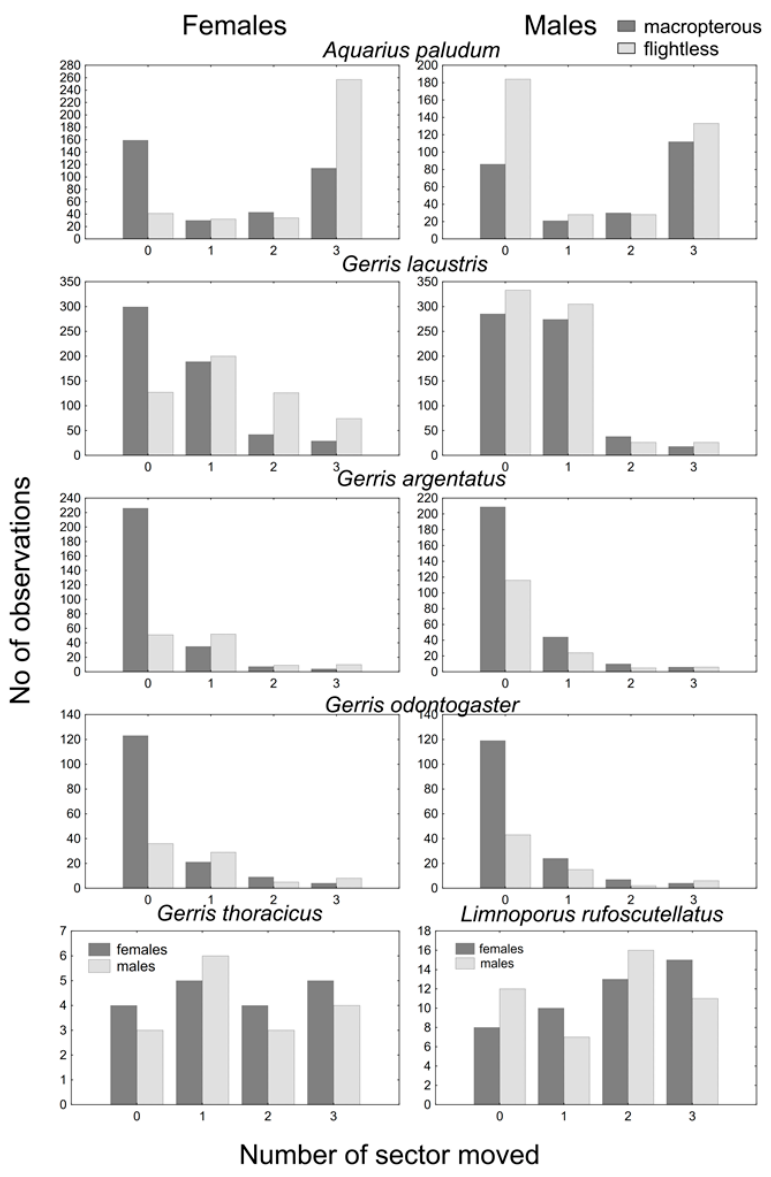
Figure 1. The score of within site movement. Both sexes and wing morphs are displayed for A. paludum , G. lacustris , G. argentatus and G. odontogaster ; only macropterous bugs are shown for G. thoracicus and G. gibbifer .